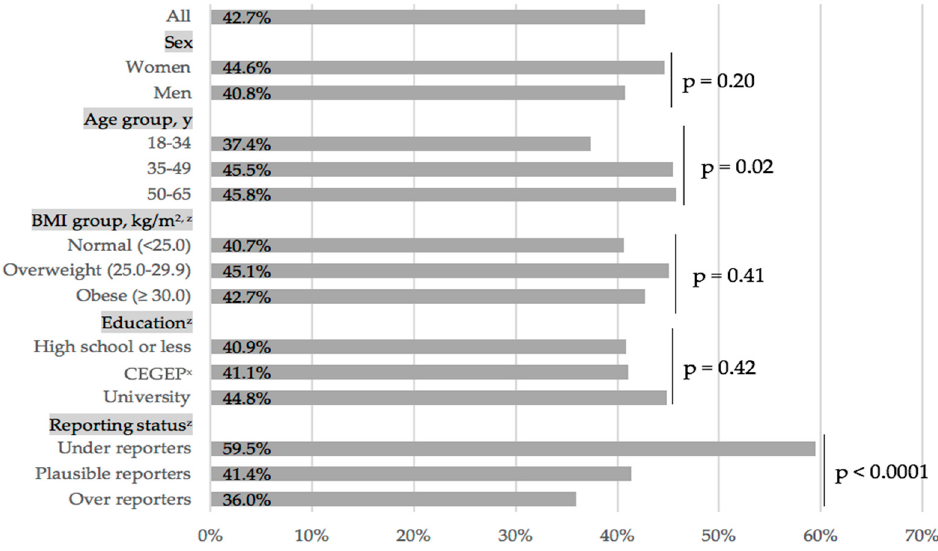
Figure 1. Proportion of individuals meeting the World Health Organization’s recommendation to consume less than 10% of daily kilocalories as free sugars, in a representative sample of French-speaking adults of the Province of Québec, Canada. A p value <0.001 was considered statistically significant. z Missing characteristics were imputed. See the Methods section for details. x CEGEP is a pre-university and technical college institution specific to the Quebec educational system. BMI, body mass index.